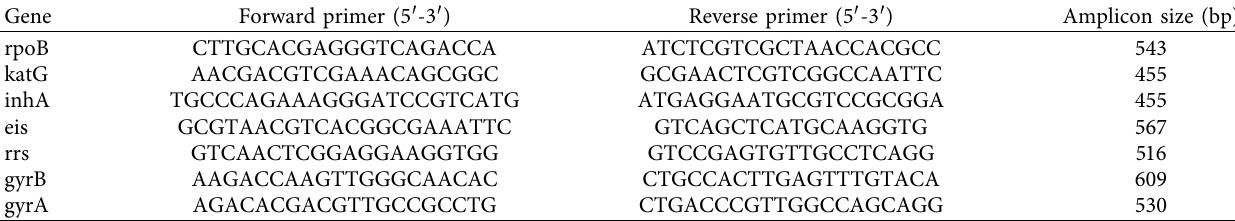
Table 1: Multiplex polymerase chain reaction primer